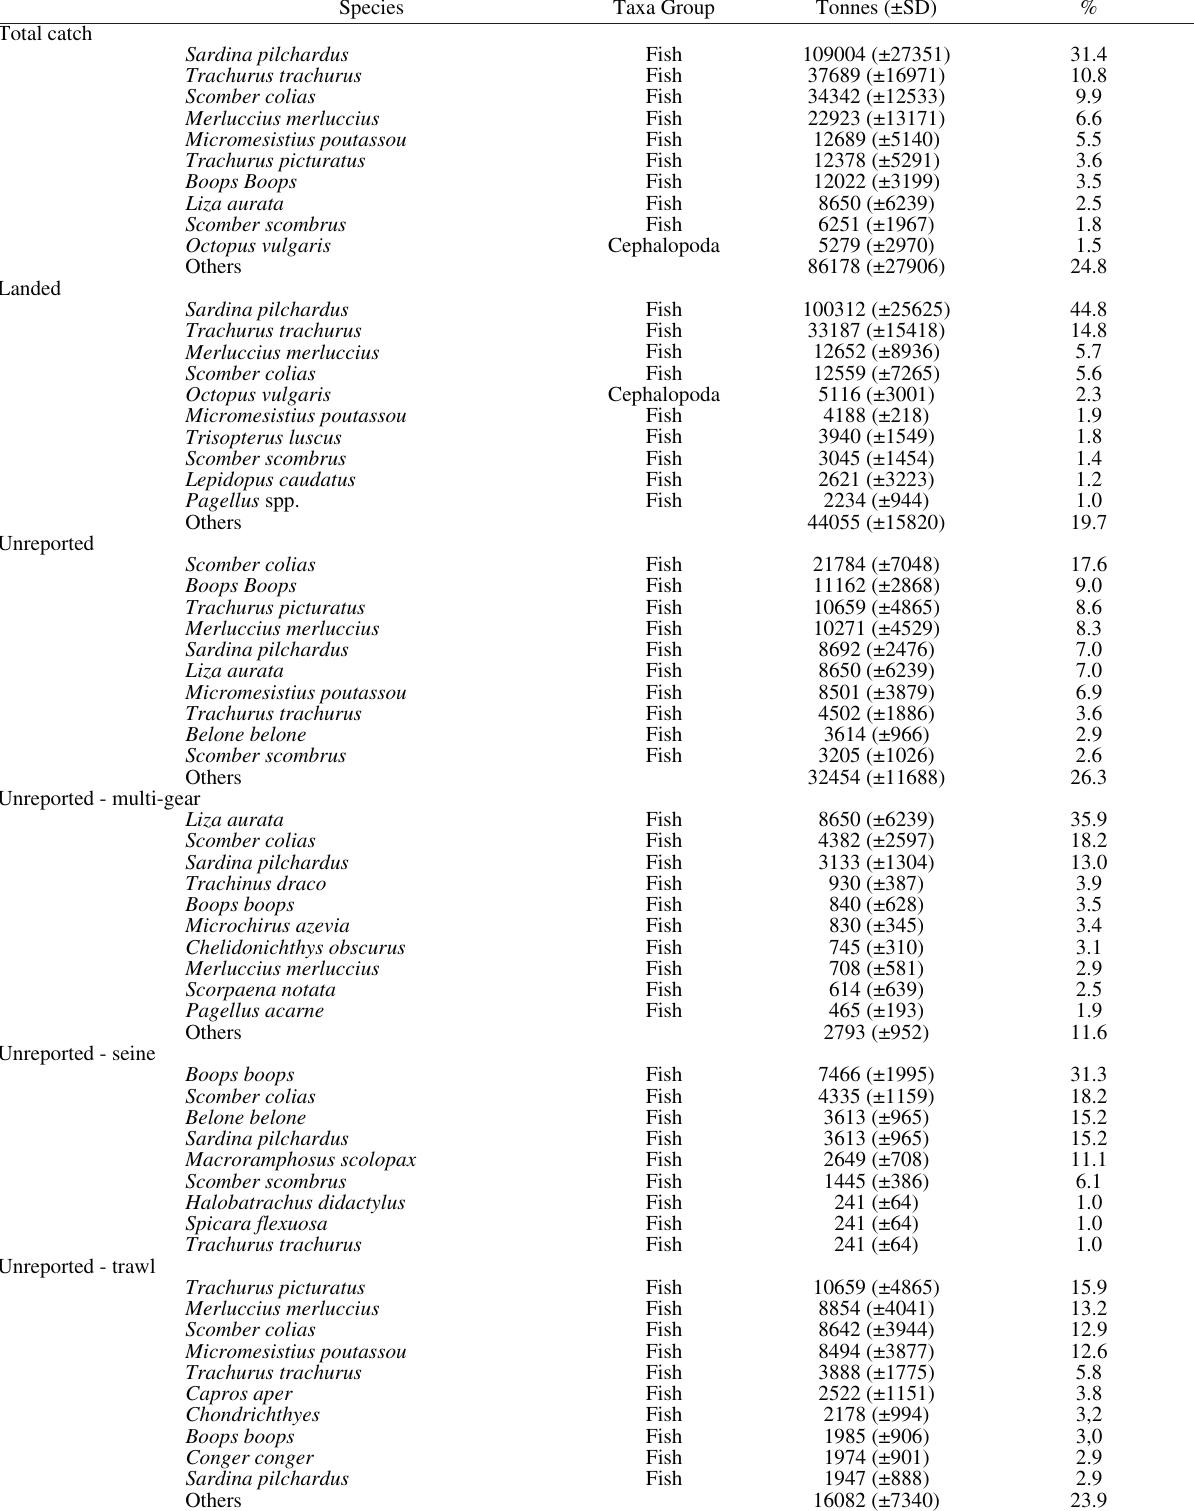
Table 3. – Top ten species landed and unreported in Portugal Mainland fisheries, for the period 1938-2009.